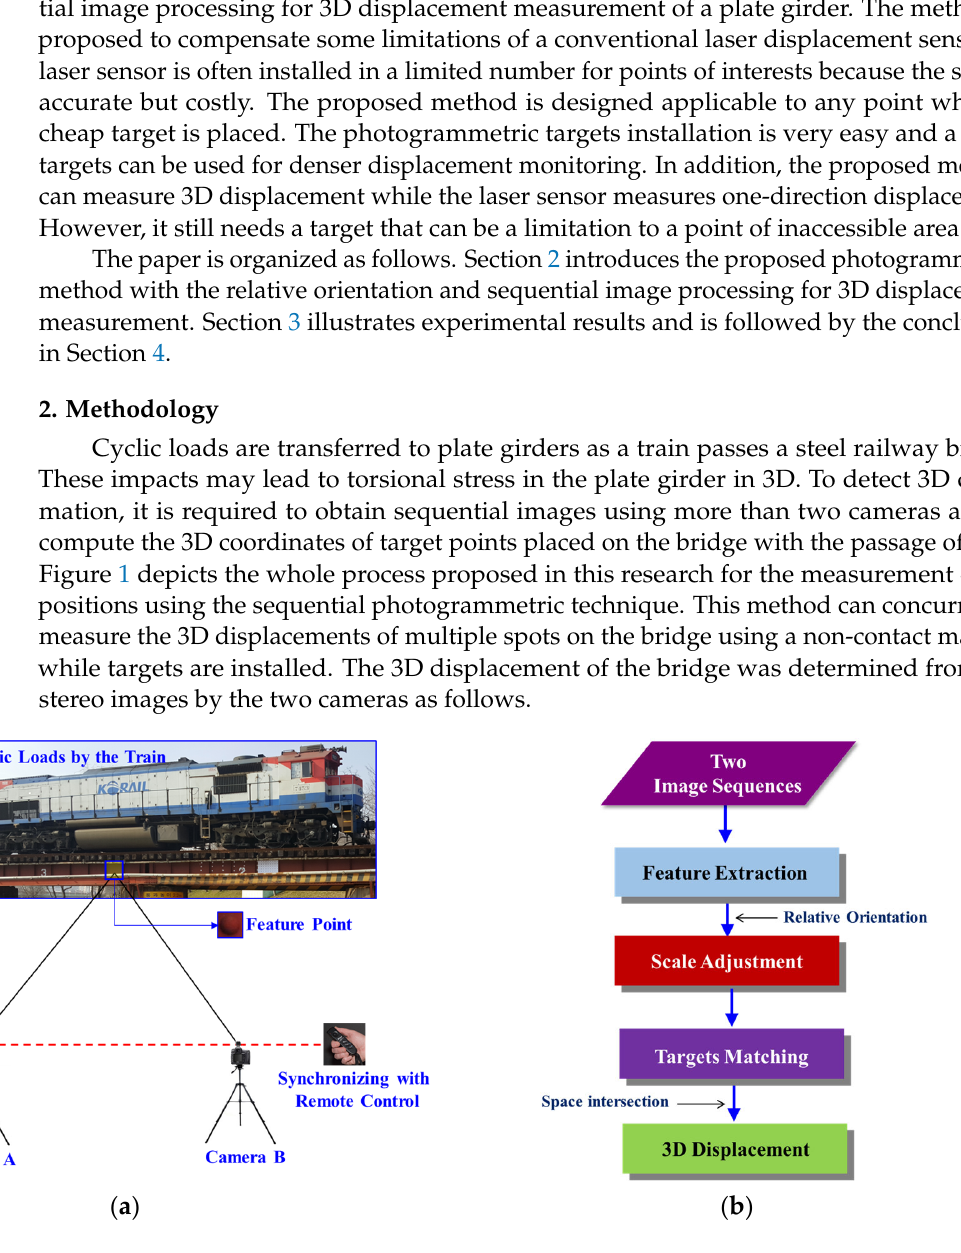
Figure 1. ( a ) Illustration to obtain consecutive stereo-image by the two cameras on the railway bridge at the moment of the train loading; ( b ) flow-chart for displacement measurement with sequential photogrammetric